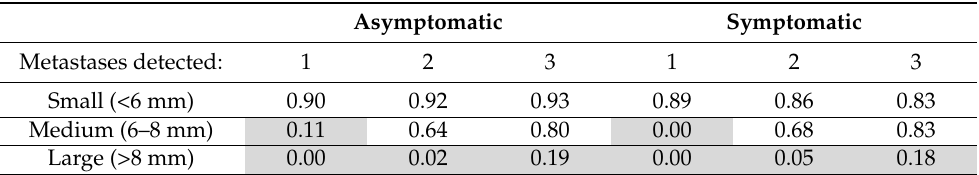
Proportions of oligo+ per risk sub-group. Grey fields represent the low-risk group. Table A10. Proportion of oligo+ within patients with detected oligo-metastases in the Random VDT scenario.